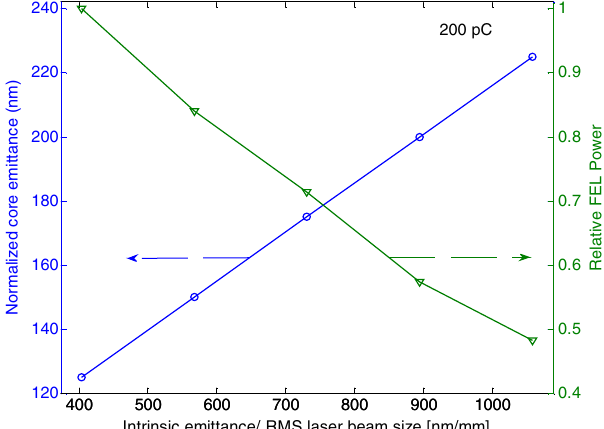
FIG. 1. Dependence of the relative FEL power as a function of the intrinsic emittance. Normalized core slice emittance is simulated for the 200 pC charge operation mode of SwissFEL for different normalized intrinsic emittance values. The corre- sponding normalized emittance at the undulator entrance for the best working points (dots) is then used to estimate the relative FEL power